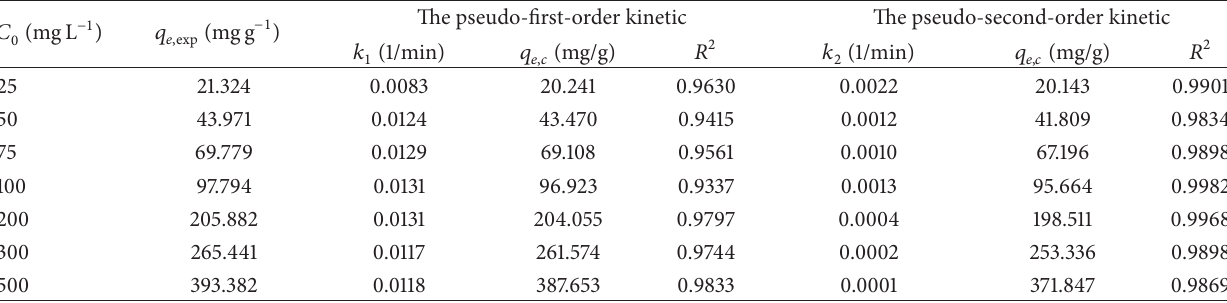
Table 10: Kinetic model parameters for TB AGLF dye adsorption on sunflower pulp at different initial dye concentrations. −1 𝐶 0 (mgL